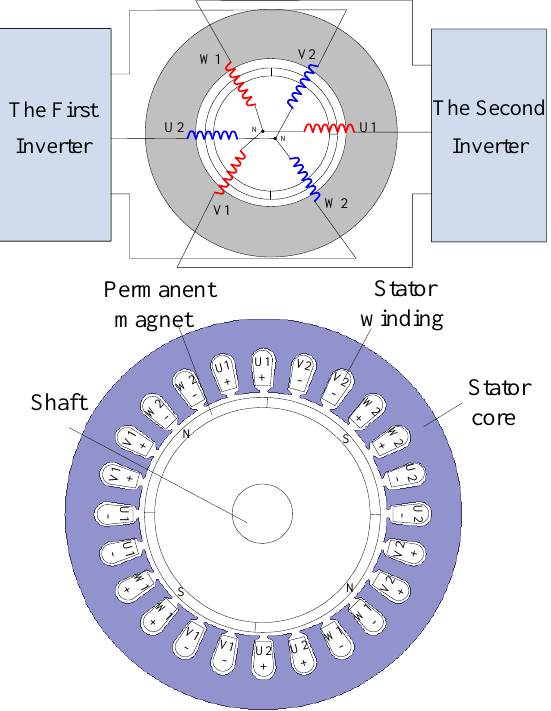
Figure 1. Schematic of a single winding bearingless permanent magnet synchronous motor.